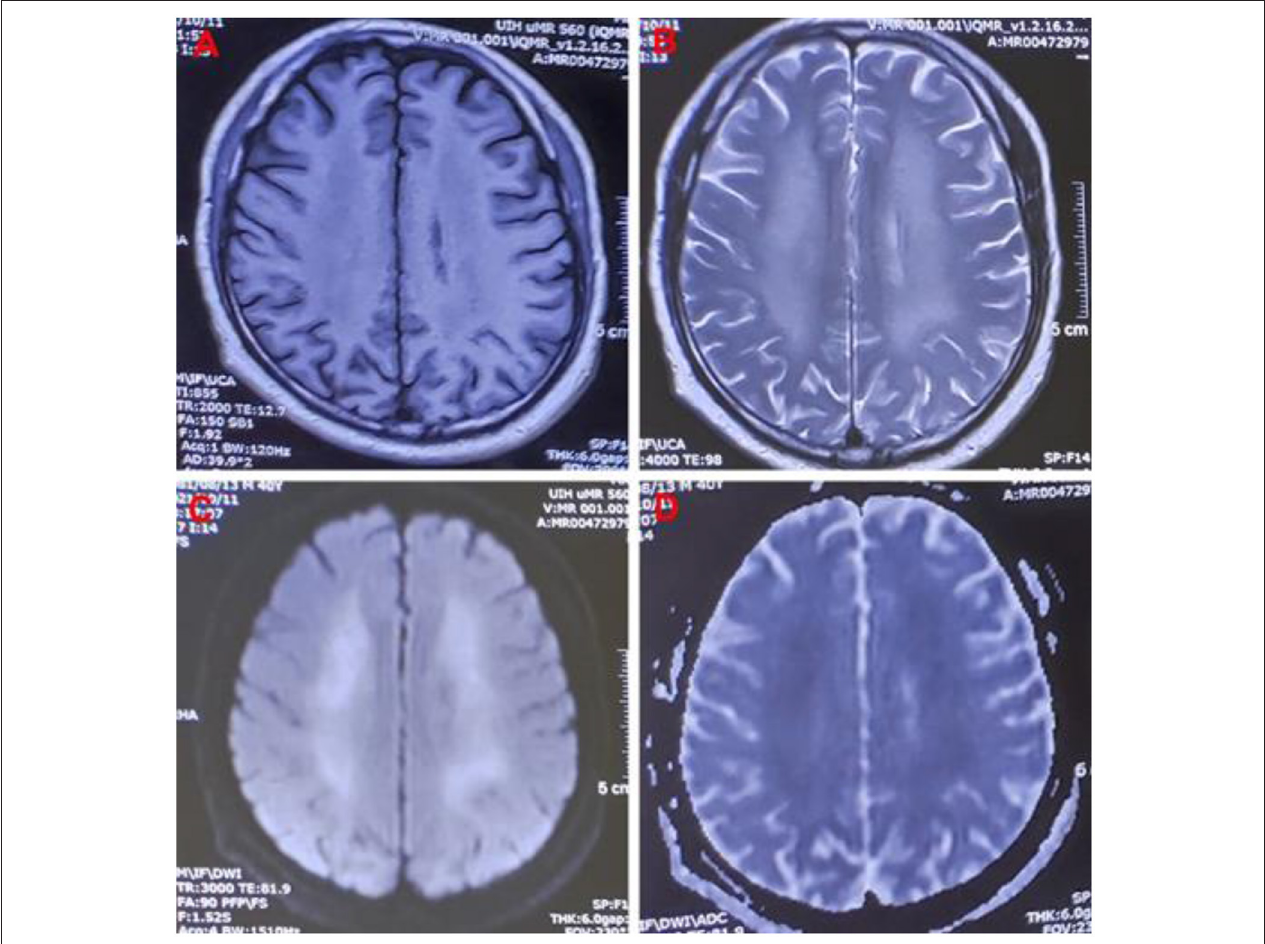
FIGURE 1 | Images of a 40-year-old man exposed to 5-Bromo-2-nitropyridine. Magnetic resonance imaging 82 days after exposure showing abnormal signal intensity on (A) T1WI, (B) T2WI, (C) DWI, and (D) DWI/ADC in the bilateral cerebral hemispheres. T1WI, T1-weighted image; T2WI, T2-weighted image; DWI, diffusion-weighted imaging; DWI/ADC, diffusion-weighted imaging/apparent diffusion